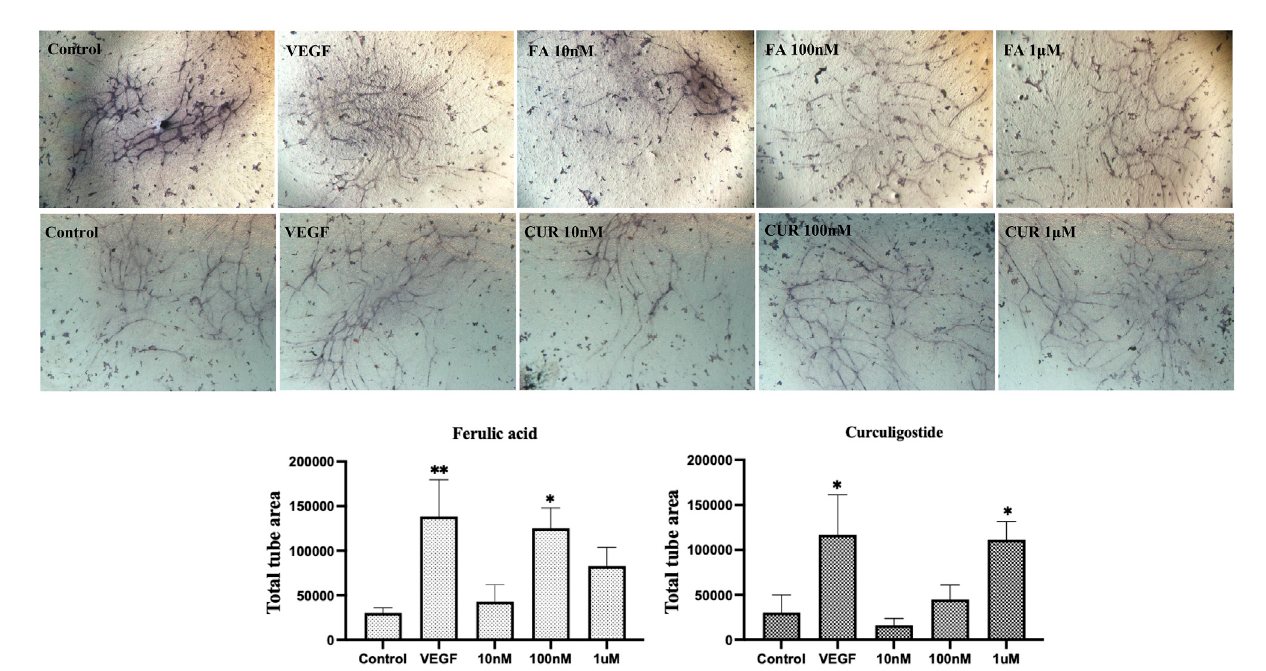
FIGURE 5 Modulationofendothelialtubeformationbyferulicacid(FA)andcurculigostide(CUR) invitro .InaHUVEC-HDFco-culturemodel,ferulicacidstimulated endothelial tube formation at 10 nM but produced an inhibitory effect at higher concentrations. Curculigostide stimulated endothelial tube formation at 10 nM – 1 μ M. VEGF was included as the positive control. Statistical analyses were performed by one-way ANOVA followed by Dunnett ’ s post hoc test. Data represents mean ± SEM ( n = 4 – 6). Compared with the control group, * p < 0.05, ** p < 0.01, *** p <